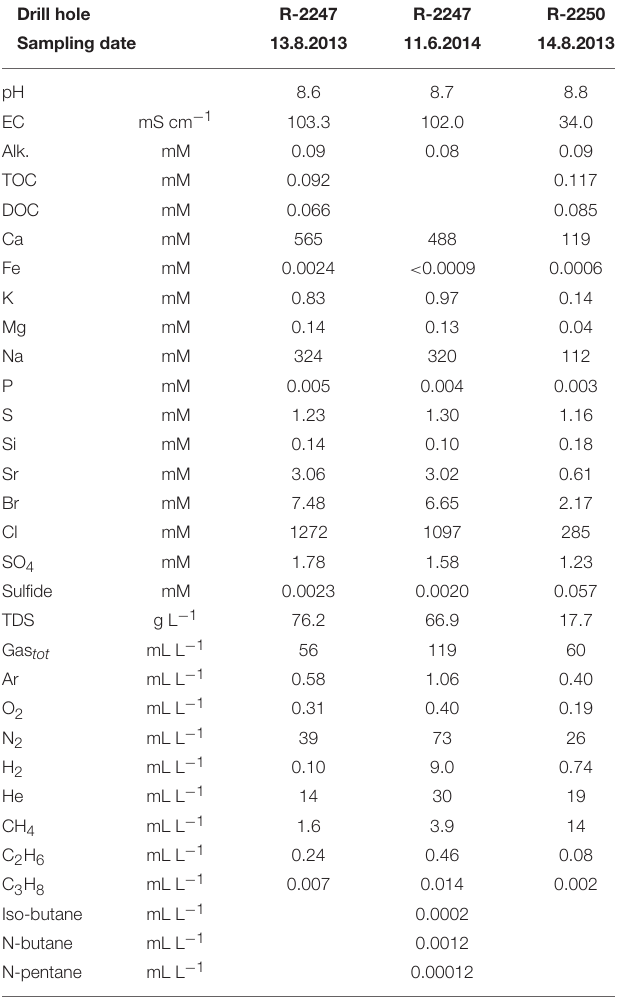
TABLE 2 | Geochemistry of groundwater in the drill holes R-2247 and R-2250 in the Pyhäsalmi mine. Drill hole